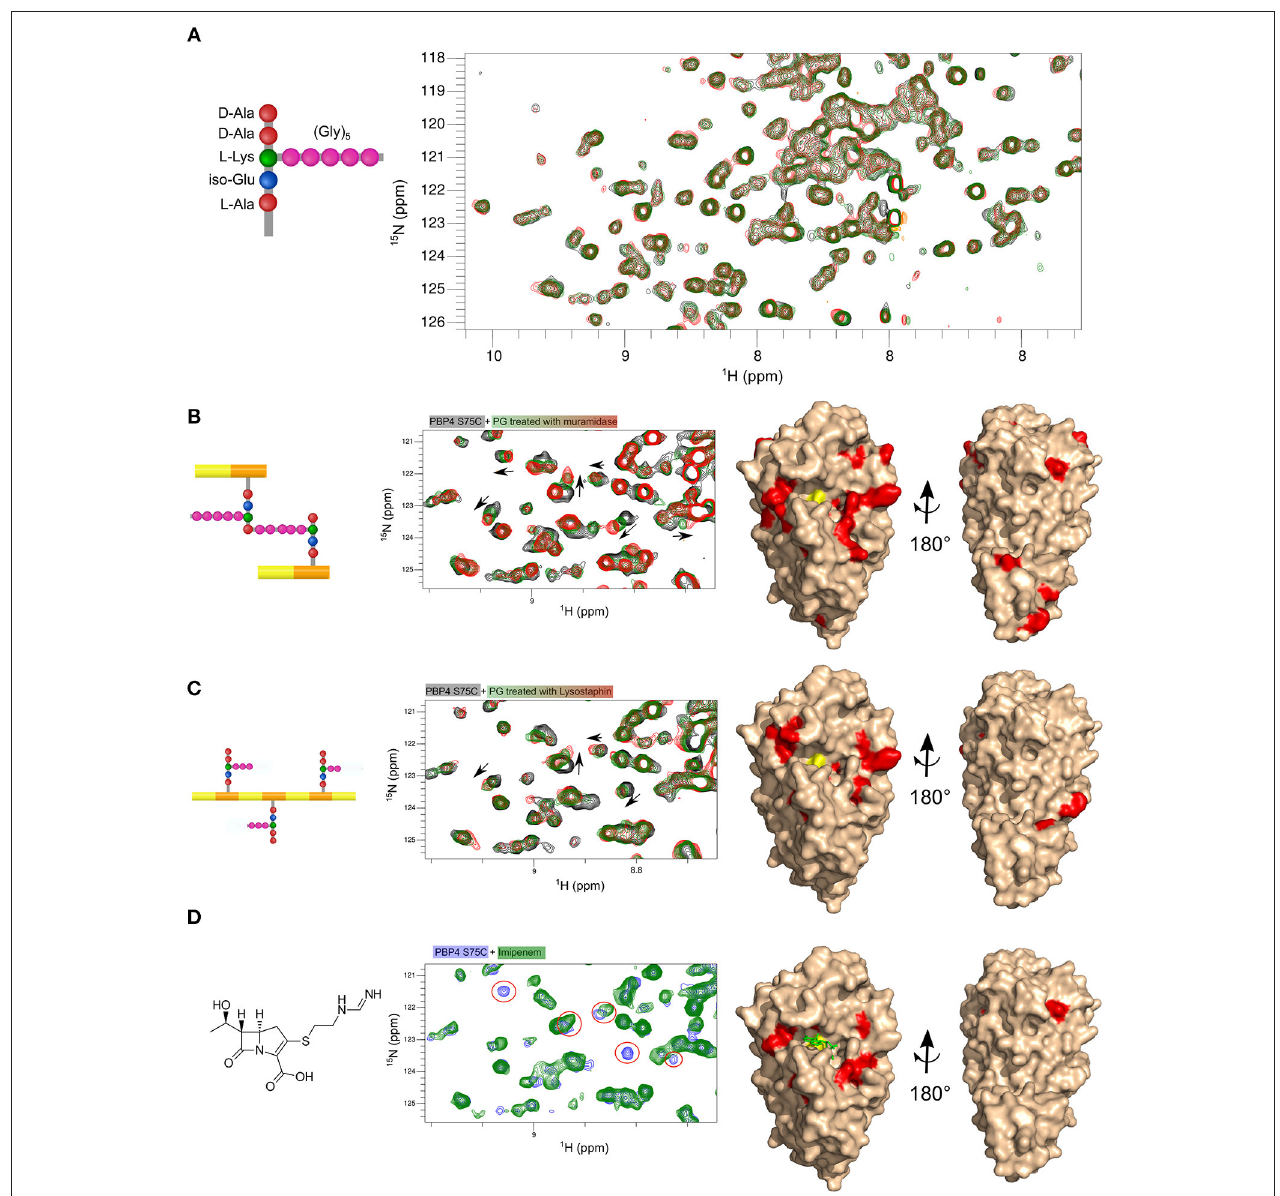
FIGURE 5 | Mapping the interaction surface of PBP4(S75C) with synthetic peptides, PG fragments and imipenem. Parts of 1 H, 15 N-BEST-TROSY spectra of PBP4(S57C) before and after addition of different ligands which are shown on the left side: (A) lactoyltetrapeptide HO-D-Lac-L-Ala-D-iGln-[L-Lys(Gly) 5 ]-D-Ala-COOH (black, green, and red with 1:0, 1:22, and 1:52 protein:peptide molar ratios, respectively, at a protein concentration of 326 µ M); (B) muropeptides from S. aureus strain SH1000 (black, green, and red with 1:0, 1:50, and 1:180 protein:fragment molar ratios for a protein concentration of 150 µ M) (C) PG fragments obtained by digestion with lysostaphin (black, green, and red with 1:0, 1:10, and 1:16 protein:fragment molar ratios for a protein concentration of 150 µ M); (D) imipenem (blue and green with 1:0 and 1:1.2 protein:antibiotic molar ratios for a protein concentration of 150 µ M). Right panels in (B–D) display a surface representation of the PBP4 structure in beige. Residues showing significant chemical shift perturbations after addition of ligands at the higher ligand-to-protein ratio are color-coded in red. The active-site serine is shown in